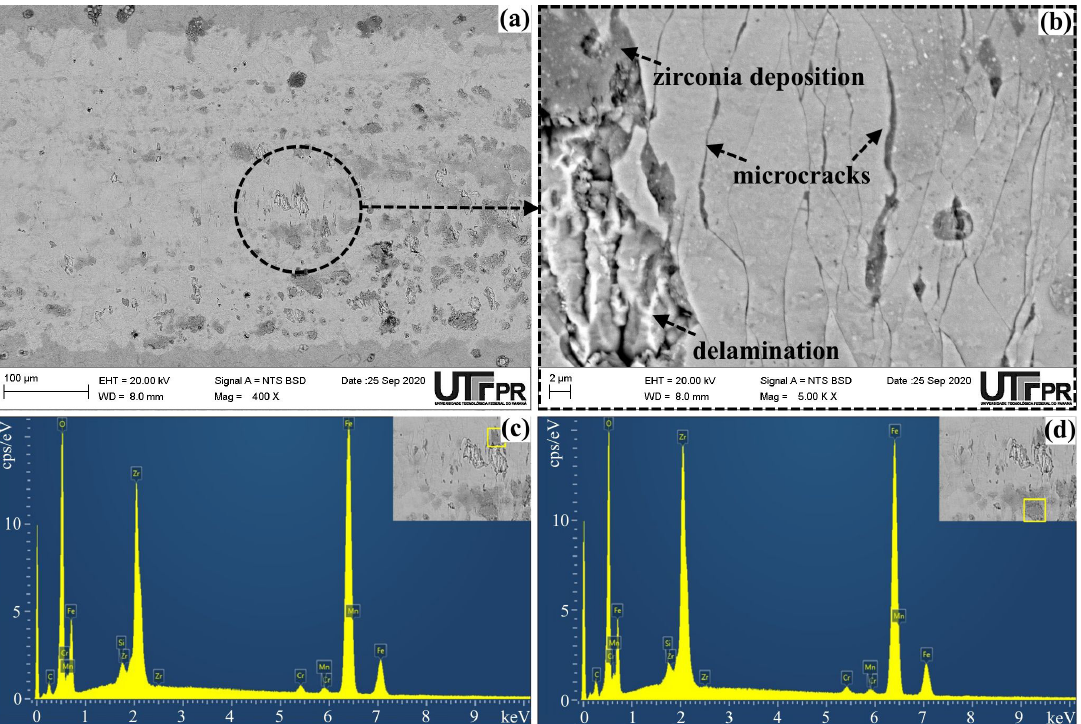
Figure 11. (a, b) SEM images and (c, d) EDS analysis of the wear tracks after reciprocal sliding wear of plasma nitrided samples for 9 h with gas mixture composition of 76 vol.%